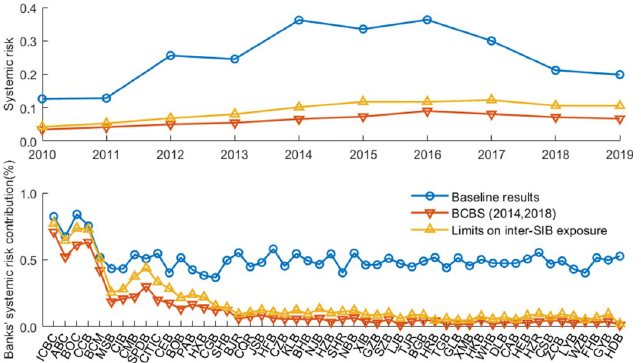
Fig 11. The systemic risk and banks’ risk contributions with limits on interbank exposure.